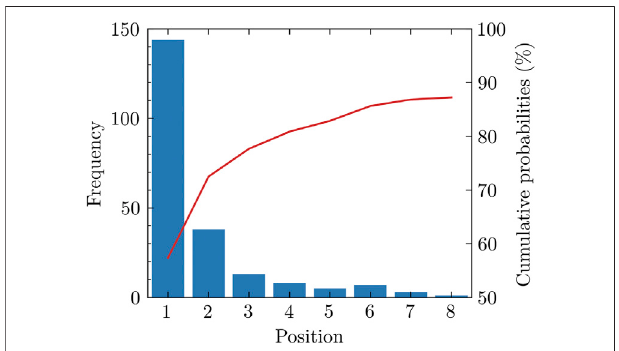
FIGURE 1 | Rank of positive pockets among all pockets. Nearly 90 percentofpositivepocketsappearamongthe fi rsteightpocketssortedbythe pocket score.